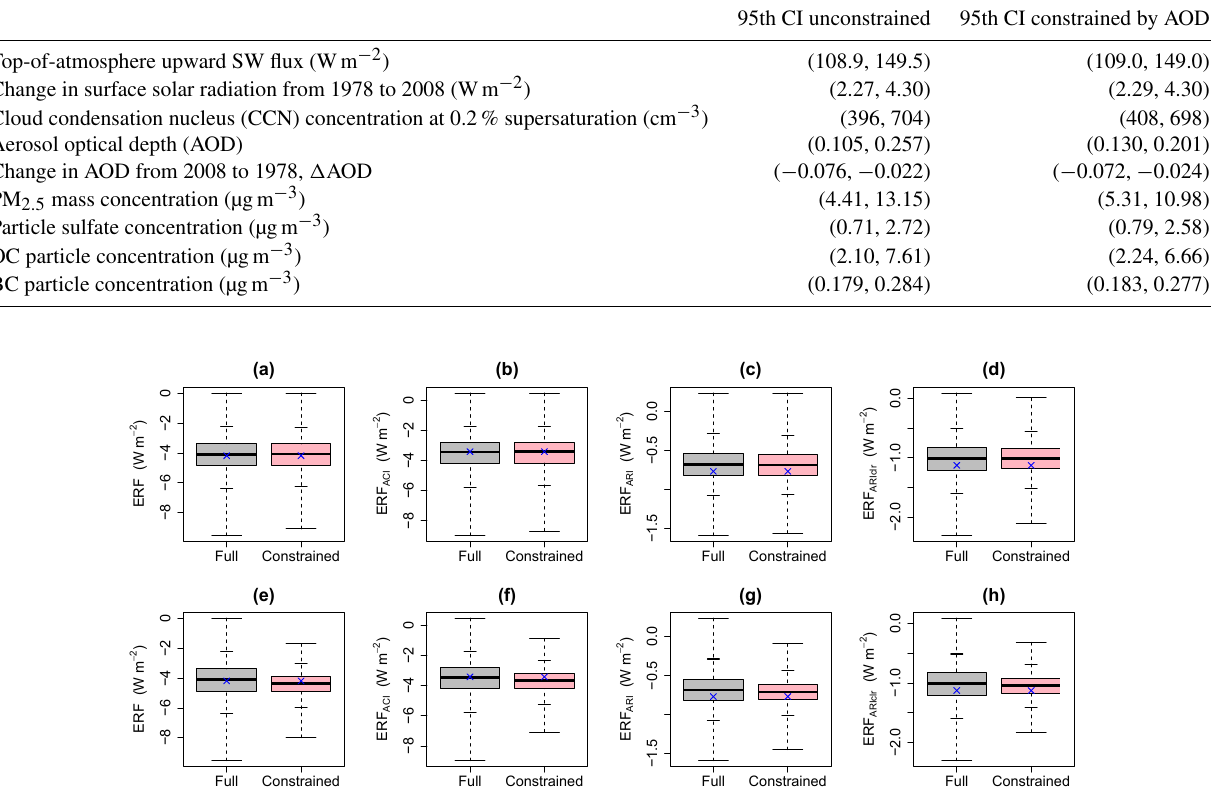
Figure 6. The effect of the AOD constraint (a–d) and all observational constraints together (e–h) on the uncertainty in the 1850–2008 forcing variables over Europe in July. Columns left to right show constraint of aerosol ERF, ERF ACI , ERF ARI and ERF ARIclr (Wm − 2 ). The boxes show the interquartile range (with the median value shown by the black line that cuts it) and the whiskers show the full range of the distribution. The short horizontal bars on the whiskers correspond to 95% credible interval bounds. The grey boxes show the distribution for the variable predicted over the original sample (4 million model variants that span the underlying parameter uncertainty) and the pink boxes show the corresponding distribution of the remaining samples after the constraint has been applied. The predicted forcing using the input combination of the model run used as the idealized observation is shown by the blue